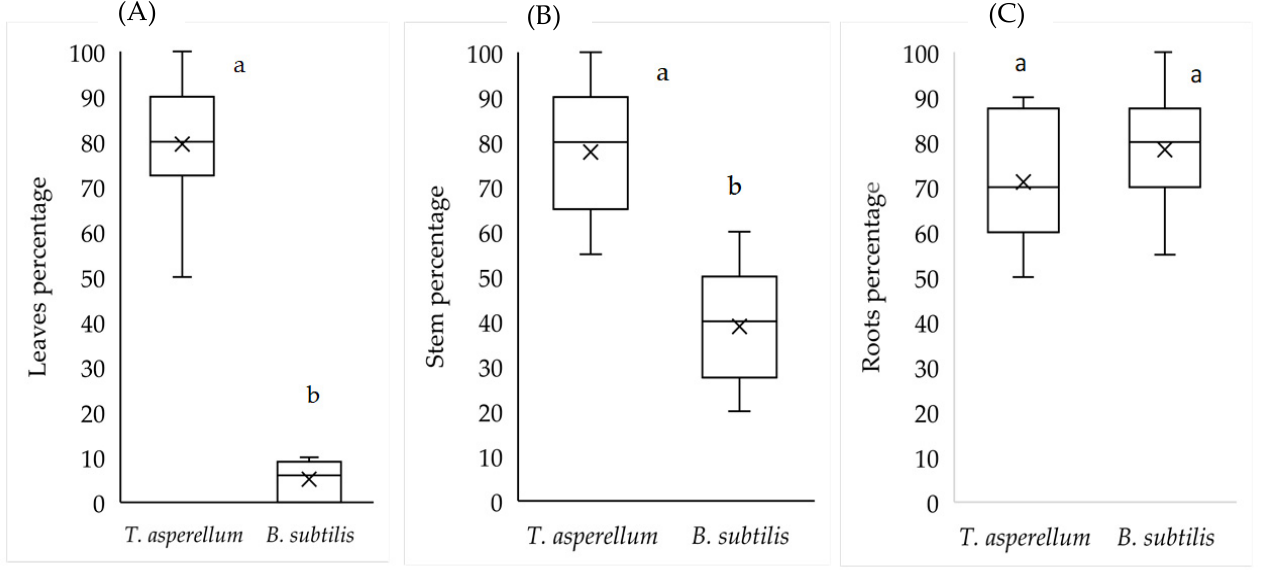
Figure 3. Isolation of endophytes in plants of M. spicata tissues. Percentage of leaf endohytes ( A ), root percentage ( B ) , and stem tissues ( C ) with T. asperellum and B. subtilis endophytes in 30-day-old plants previously inoculated under in vitro conditions. Treatments not sharing the same letter(s) are statistically significant at p < 0.05; Tukey HSD .